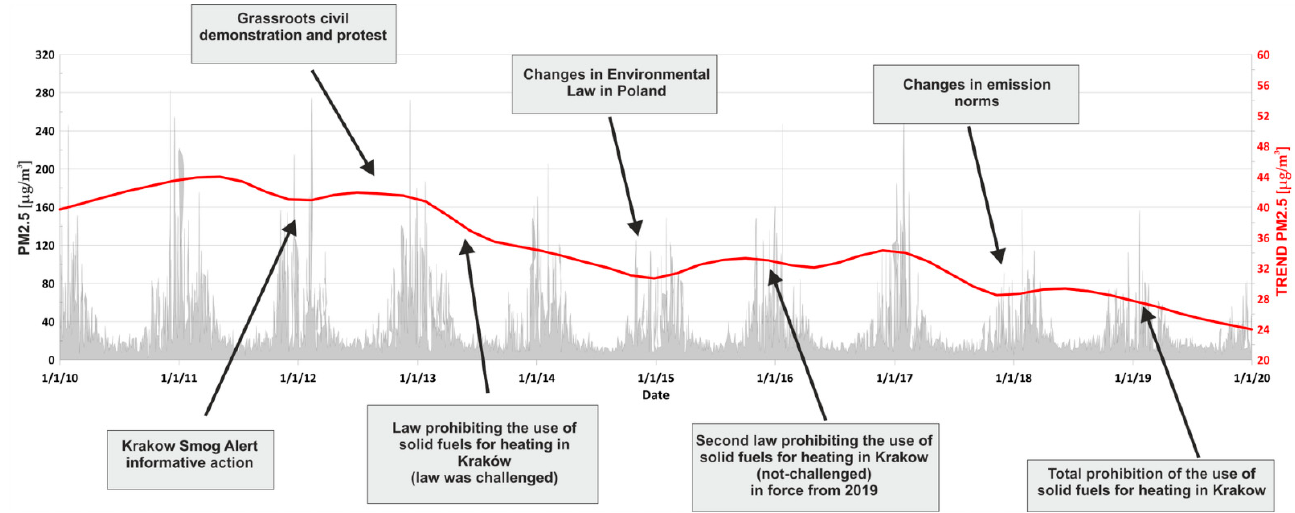
Figure 2. Krakow’s PM2.5 concentration (grey) and its STL trend (red) in the years 2010–2019 together with major law changes and grassroots action.